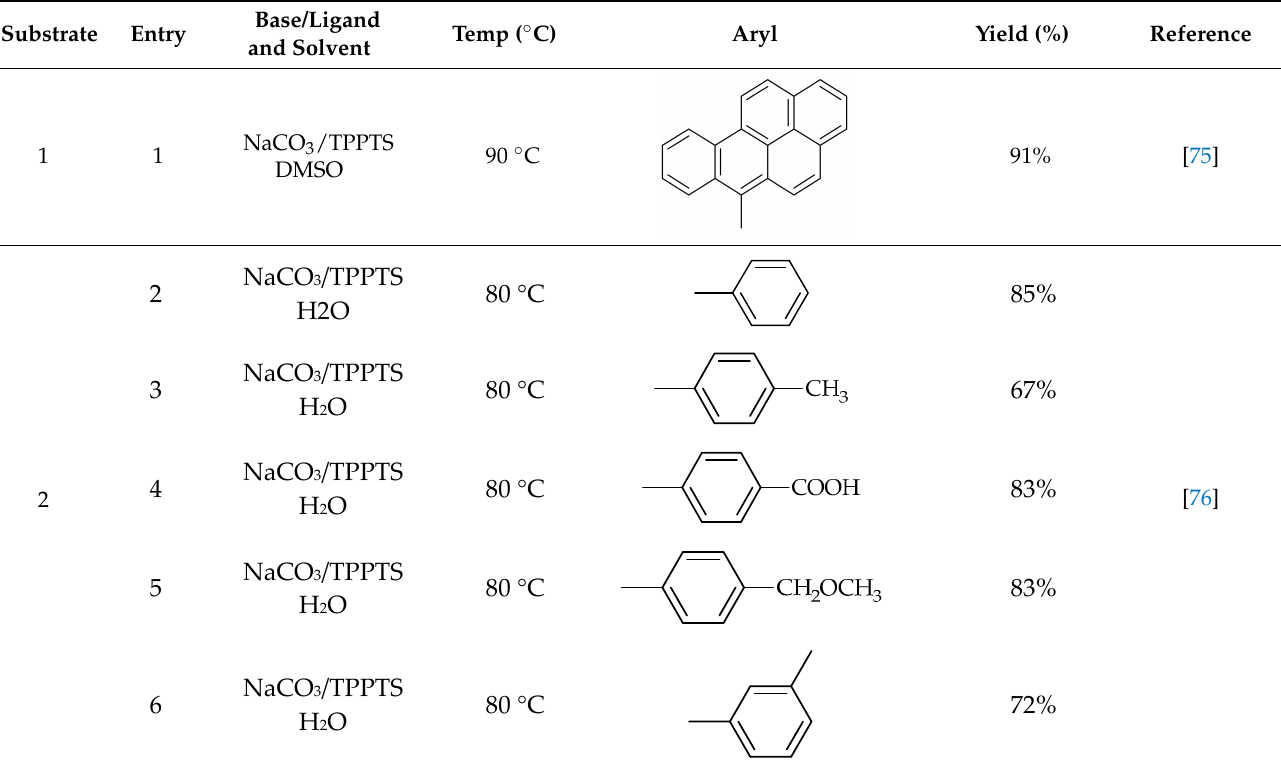
Table 1. Palladium (Pd) mediated the direct arylation at the C8 position of various purine derivatives. The structures of substrates are described in Figure 5.